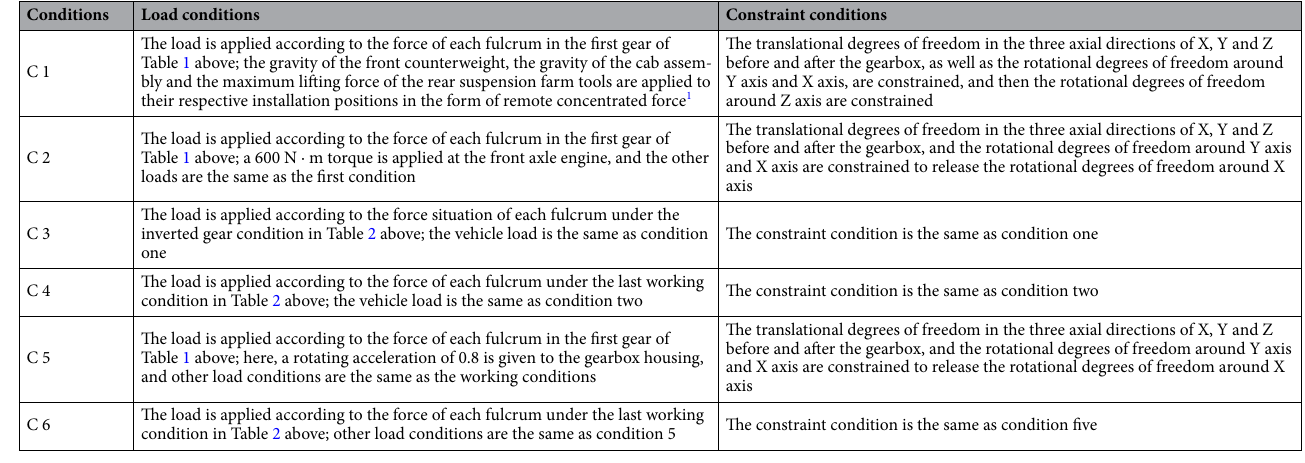
Table 5. Boundary conditions of each working